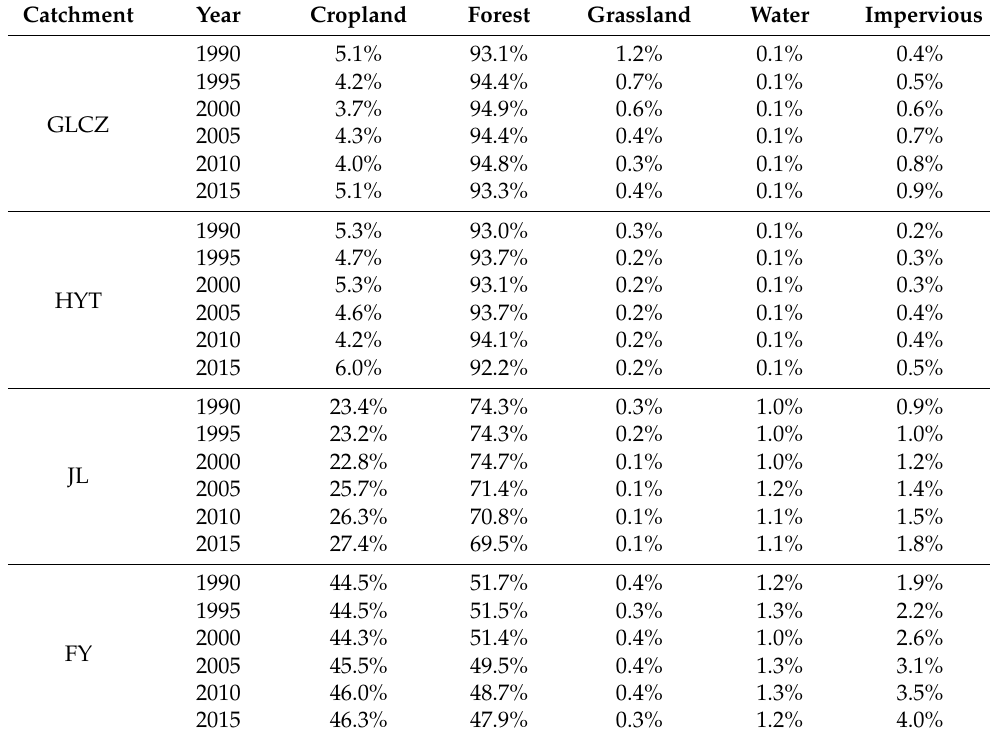
Table 2. Land-use area in sub-basins during the study period.